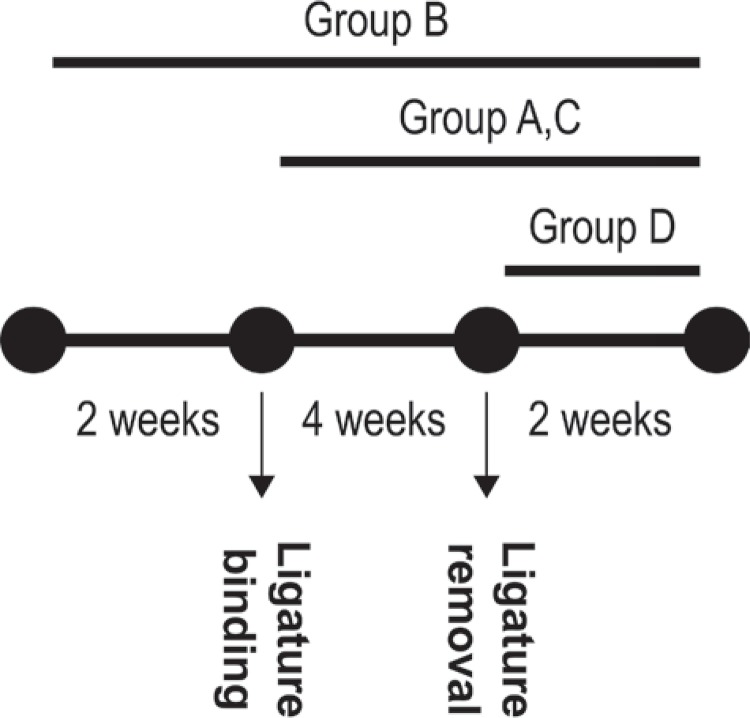
Designation of the experimental groups. Group A: control; Group B, C, and D: grape seed extract (GSE) applied groups